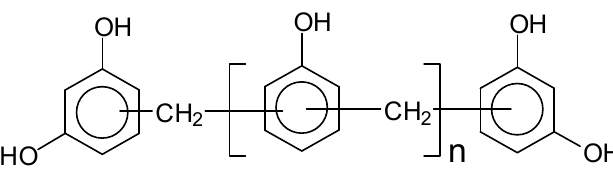
Scheme 4. Schematic representation of a PRF resin.